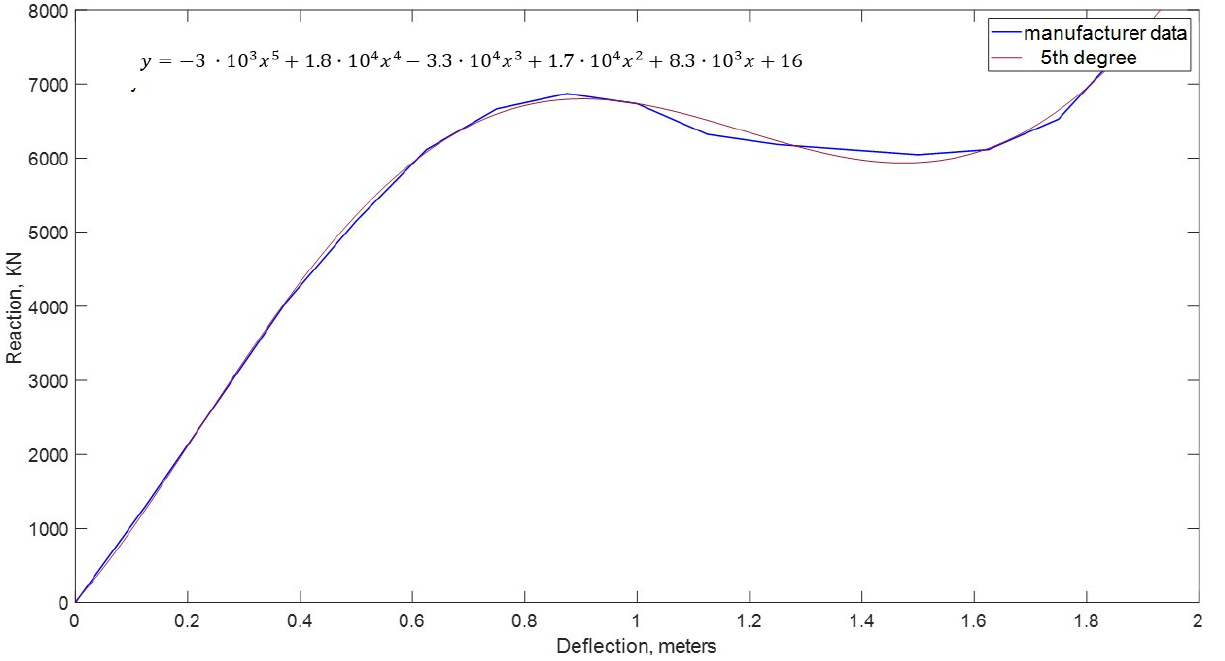
Figure 6. Stiffness curve of the SCN2500 F3.1 fender. The 5th degree polynomial was approximated via MATLAB.